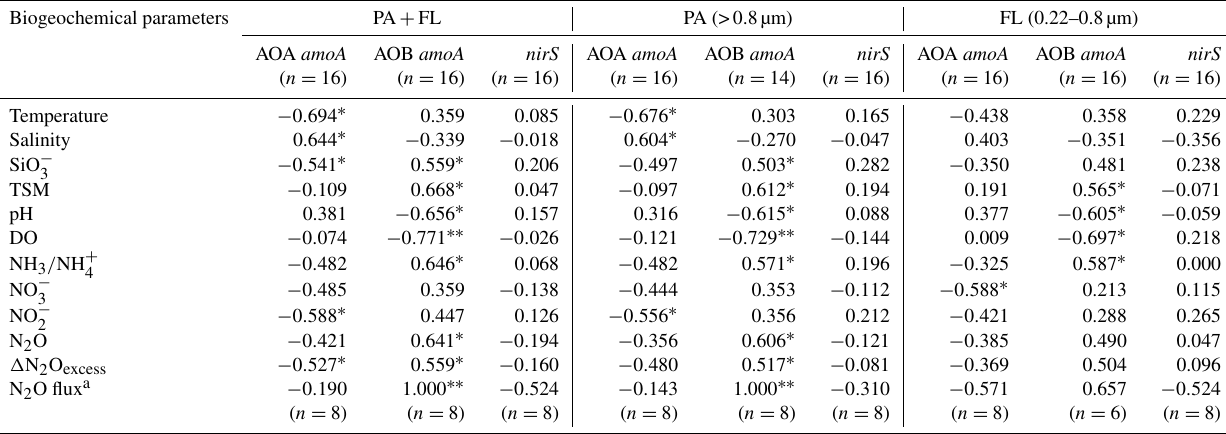
Table 1. Rho ( ρ ) values for the relationships between nitrifier and denitrifier gene abundances and biogeochemical parameters in the Pearl River estuary. Biogeochemical parameters